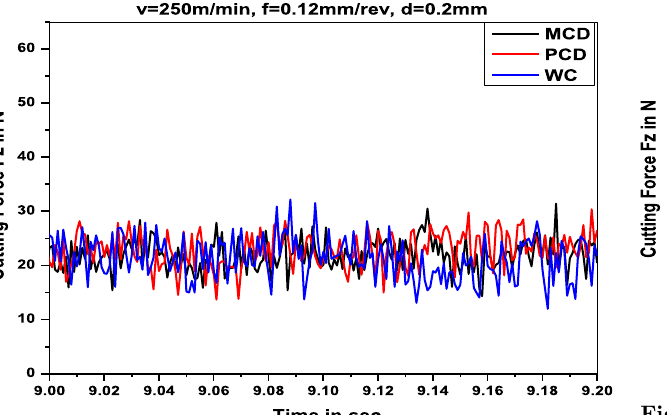
Fig. 9. Dynamic component of cutting force vs. time graph at v = 250m/min, f =0.12 mm/rev, d = 0.2mm.